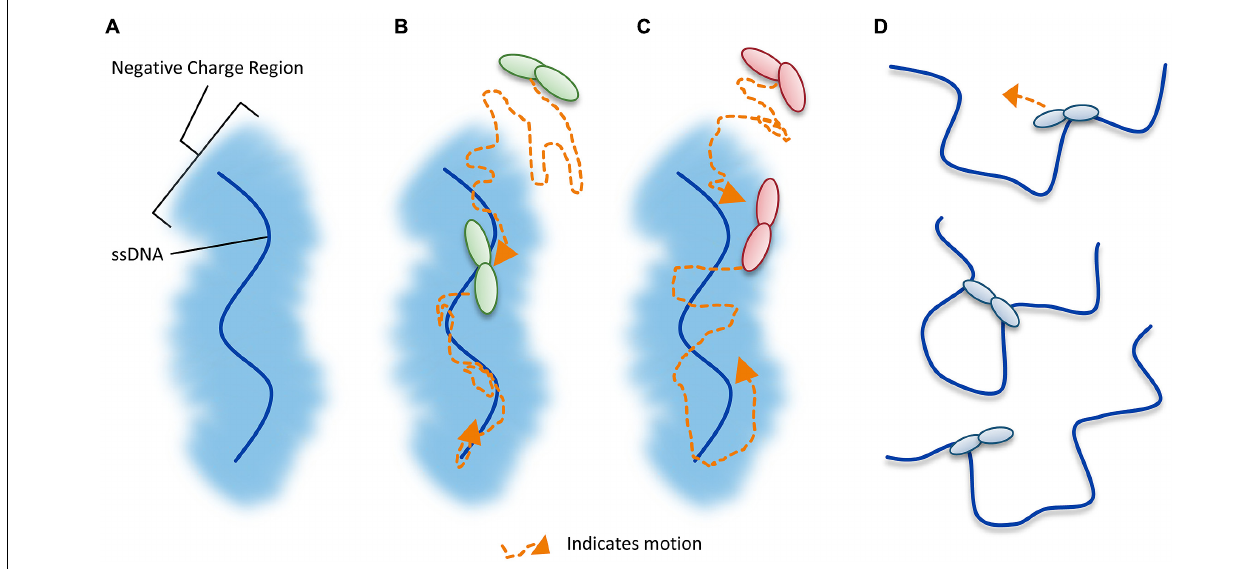
FIGURE 4 | Illustration of DNA scanning by facilitated diffusion. (A) Sketch of DNA showing the negatively charged region of DNA important for facilitated diffusion of A3 enzymes. (B–D) Enzyme in sketches is shown as a dimer, although the oligomerization state may vary with different A3 enzymes. (B) Sketch depicting a 1-dimensional DNA scanning path by sliding. Dotted line indicates path of enzyme (orange). Sliding enables an in depth search of local areas of a substrate. (C) Sketch depicting a 3-dimensional DNA scanning path by jumping. Jumping enables larger translocations on DNA substrates, but lacks a local search process.